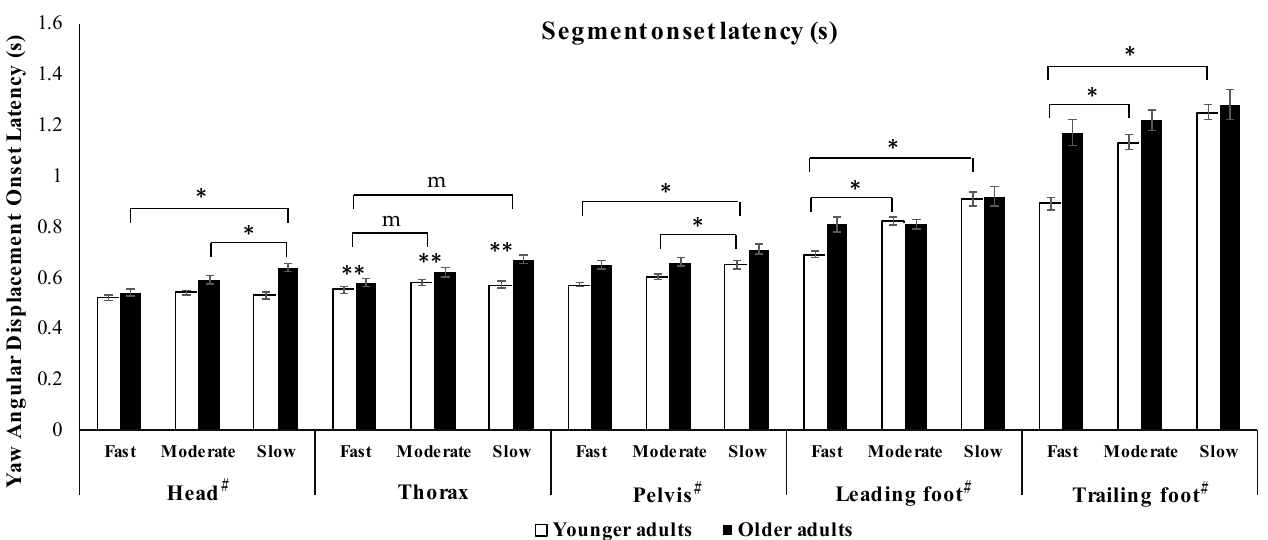
Figure 4. Bar graph showing the mean onset latencies with turn speed. There was a significant main effect of turn speed on the timing of reorientation onset for all segments. Values are mean ± SEM. # Indicates a significant interaction ( p < 0.05) from MM ANOVA. * Indicates post-hoc pairwise comparisons of turning speeds within-group from RM ANOVA. ** Indicate main effects of group and turning speed from MM ANOVA. m Indicates post-hoc pairwise with a Bonferroni adjustment for multiple comparisons from MM ANOVA. Table 1. Mean and standard deviations (SD) and interaction between group and turning speed for whole-body coordination and stepping characteristics variables which performed by MM ANOVA.